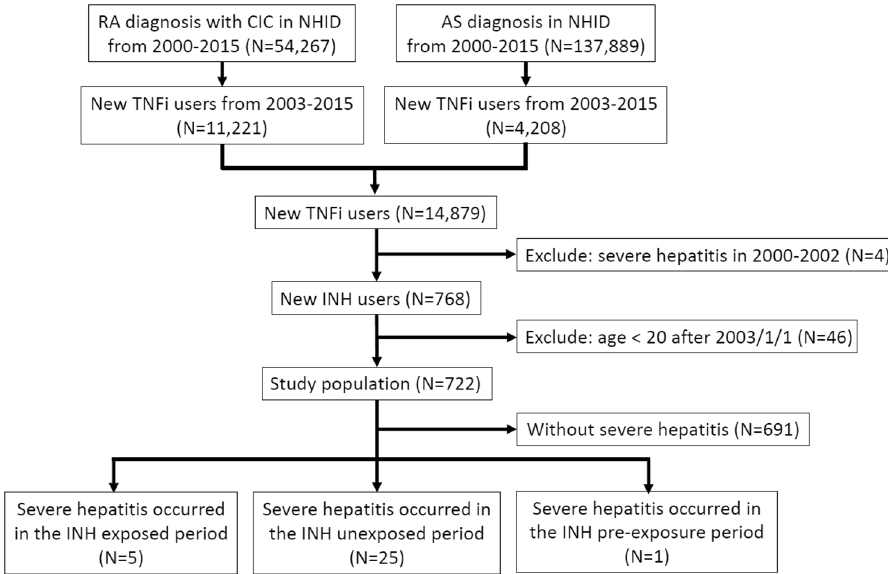
Figure 2. Flow diagram showing patient population of cohort selection.